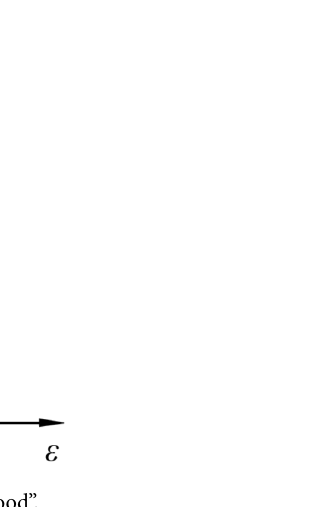
Figure 2. Curve of the rock’s “limit strength